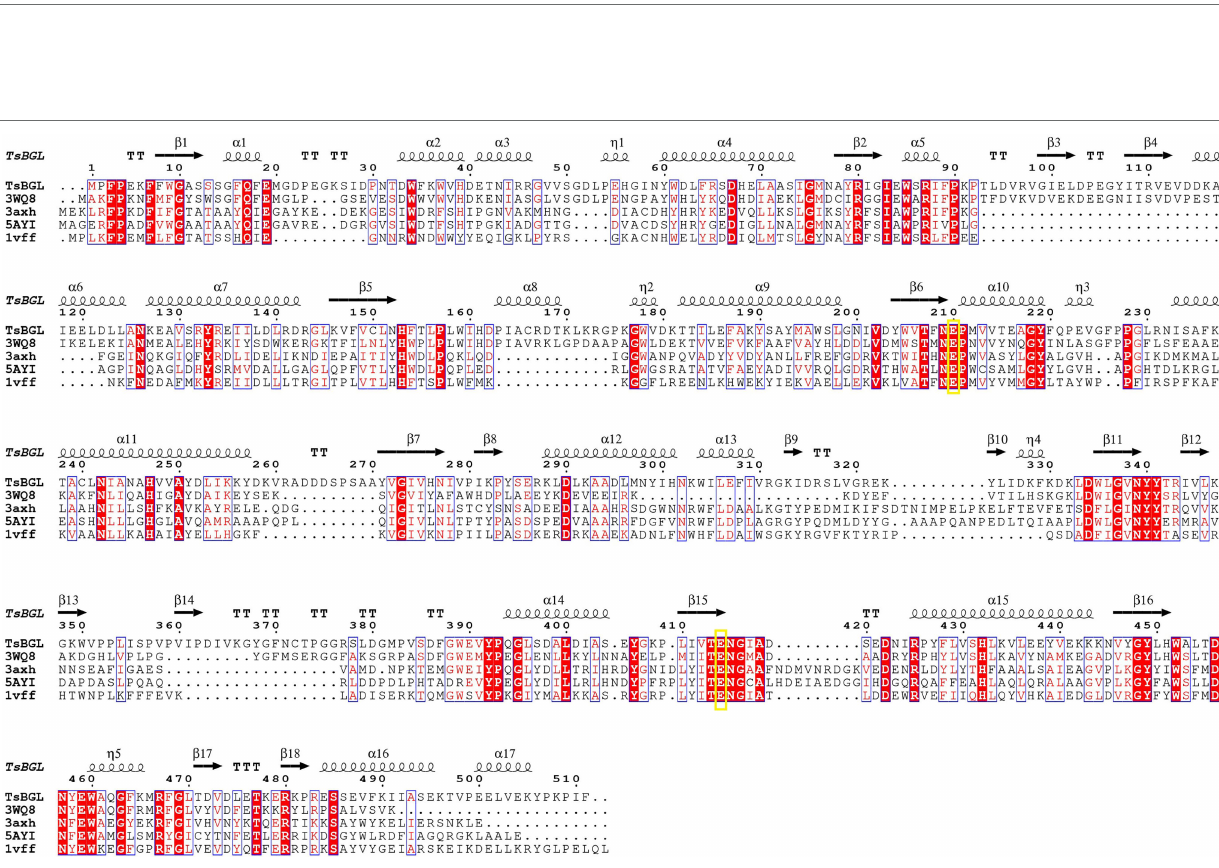
FIGURE 3 | (A) Cartoon representation of TsBGL with the label secondary structure elements, α -helices were shown in red, and β -strands were shown as yellow arrows. (B) Topology diagram of TsBGL. The α -helices and β -strands are red cylinder and pink arrow, respectively.